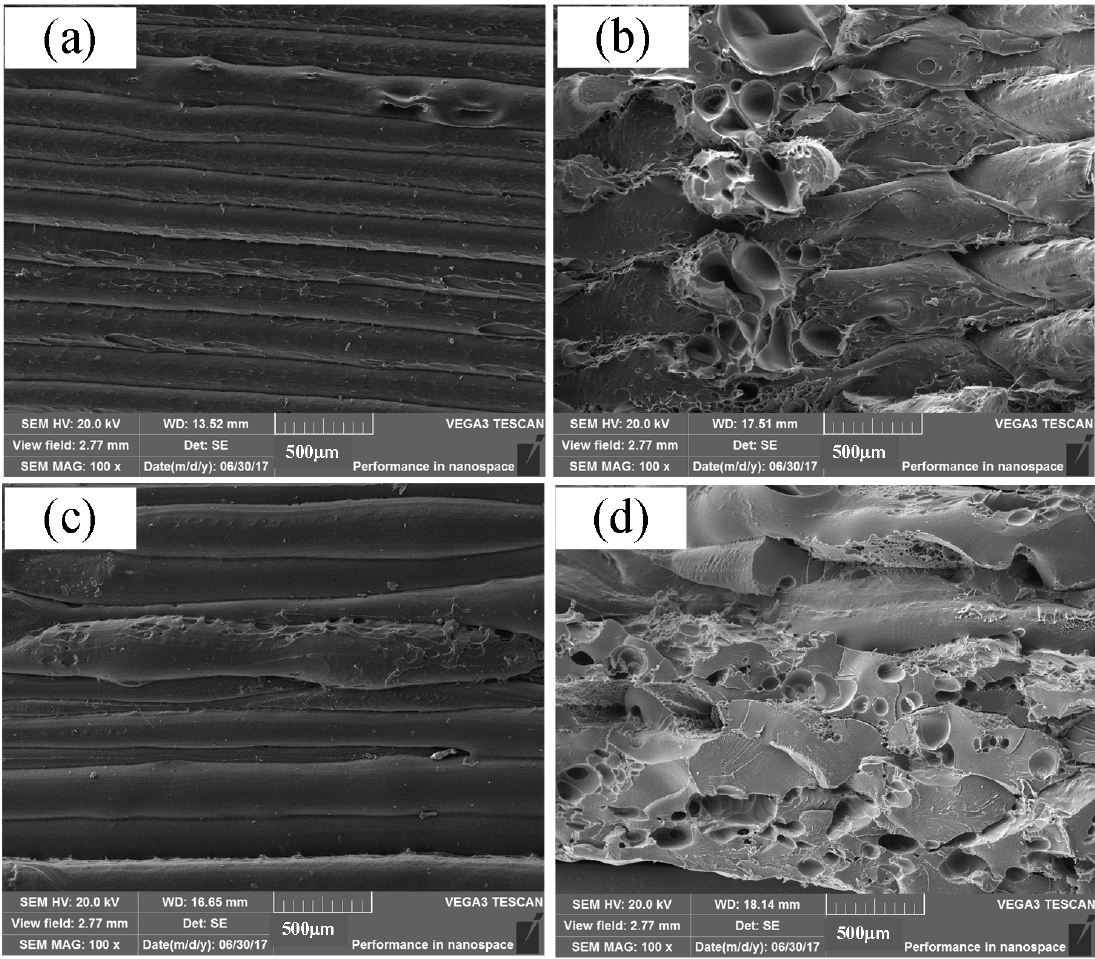
Figure 6. Microstructure and fracture surface. ( a ) side face microstructure of tensile specimen No. 7; ( b ) No. 7 fractured surface of tensile sample No. 7; ( c ) side face microstructure of tensile sample No. 4; ( d ) fractured surface of tensile sample No. 4.